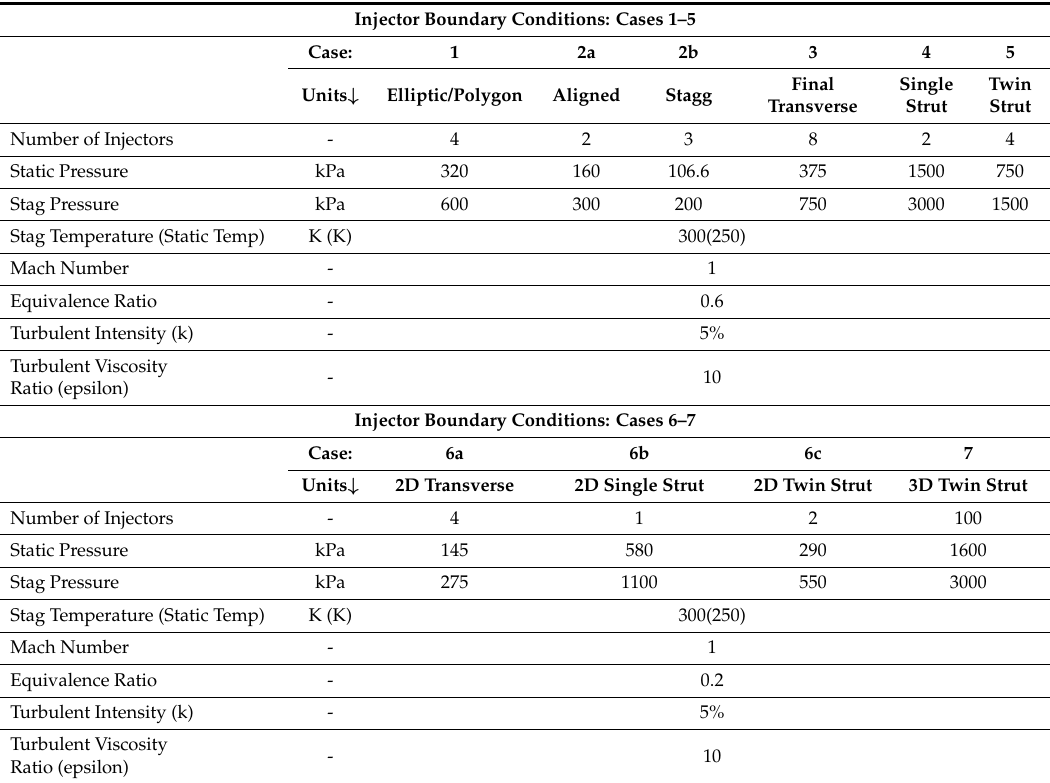
Table A4. Injector Boundary Conditions—Cases